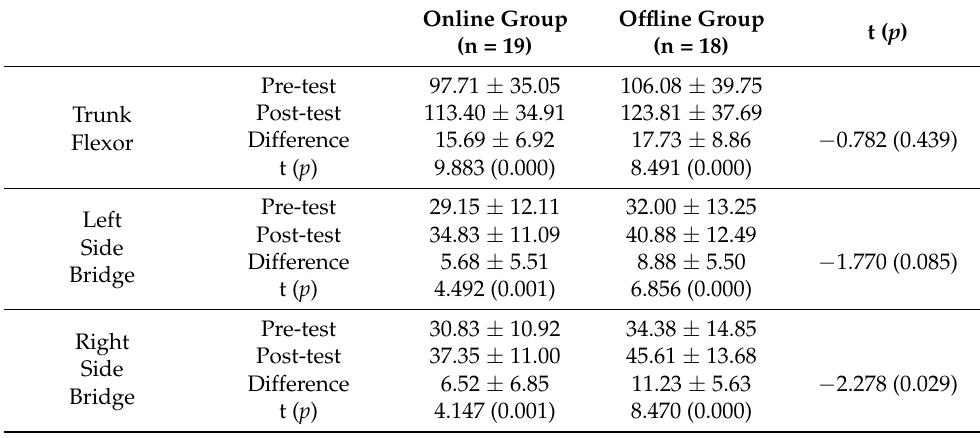
Table 4. Static trunk endurance (sec) (N = 37).